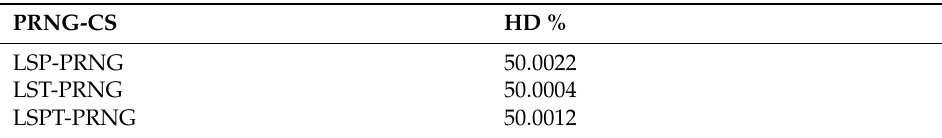
Table 6. Values of HD for the proposed PRNGs-CS.